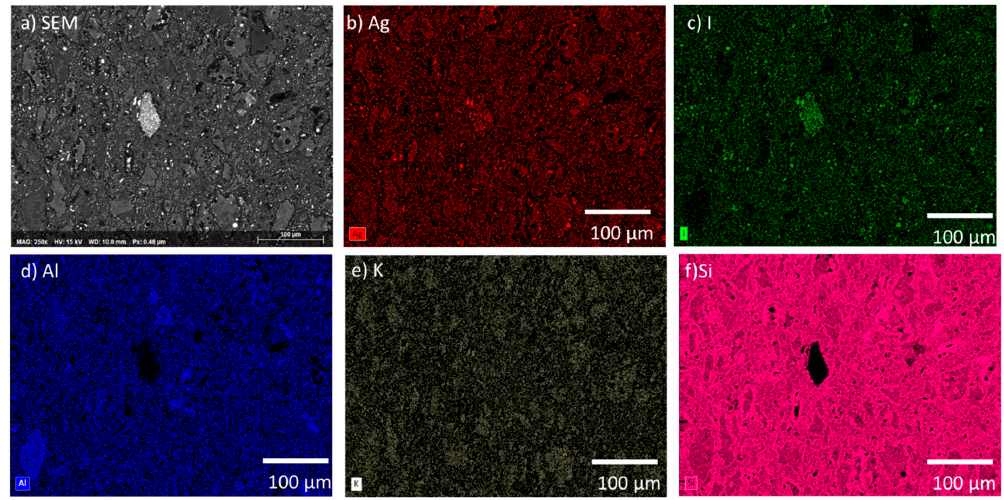
Figure 4. Microstructure of the AgZ 1-8 sample shown by: ( a ) SEM micrograph; and the corresponding EDS maps of: ( b ) Ag; ( c ) I; ( d ) Al; ( e ) K; and ( f ) Si. The large white inclusion in ( a ) is Fe (source not known) with AgI particles within the structure.